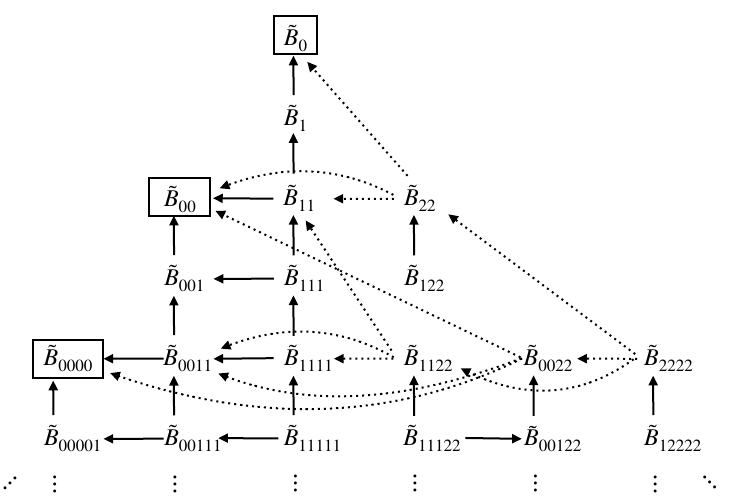
Figure 2 . Schematic roadmap for PV reduction of two-point FVC tensor coefficients. The solid and dashed lines stand for the recursive applications of eq. (3.16) and eq. (3.17), respectively. The boxed tensor coefficients are taken as the